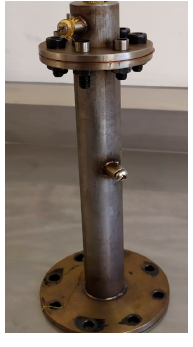
Figure 7. Stripper. Figure 7. Stripper.